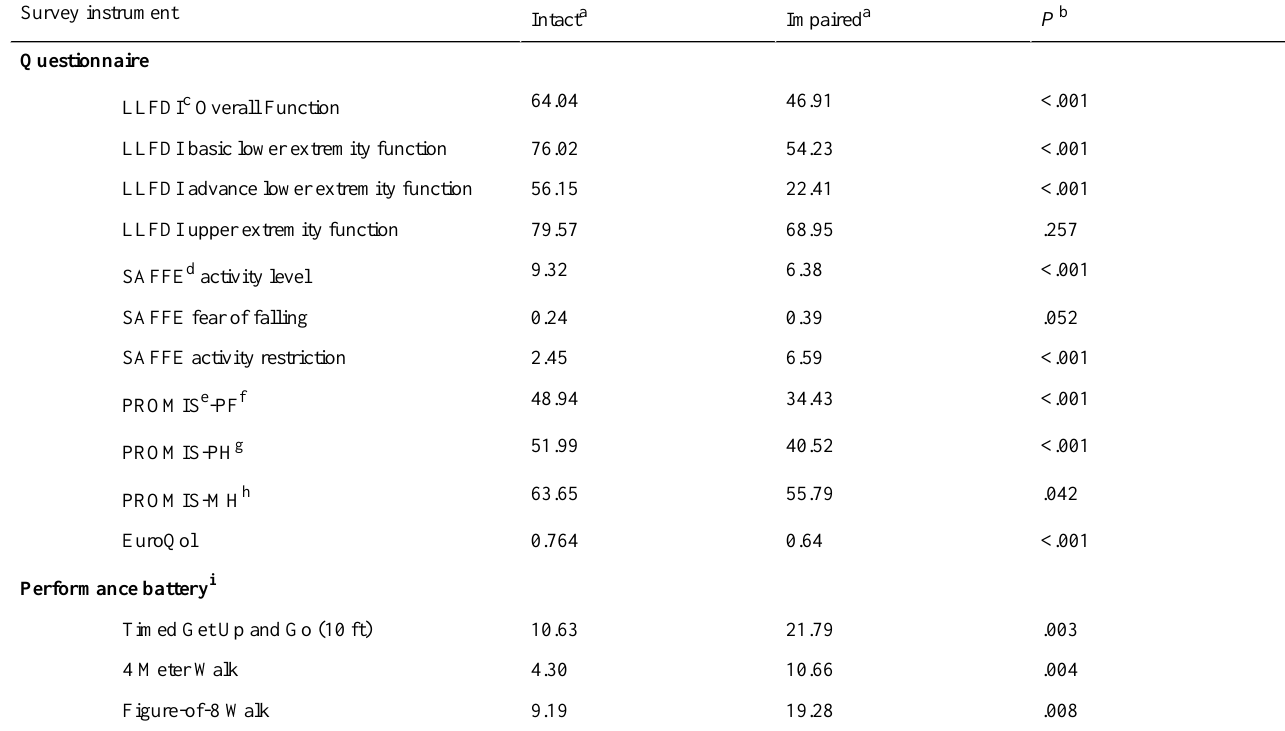
Table 2. Statistical significance of standard questionnaire and physical performance battery in discriminating functionally impaired from functionally intact